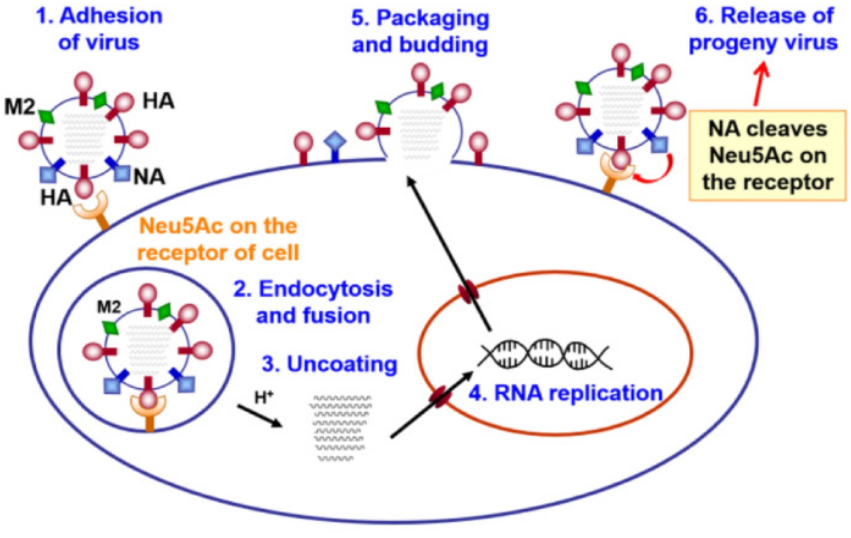
Figure 7. “Magic bullet” approach for inactivation of influenza viruses [44].